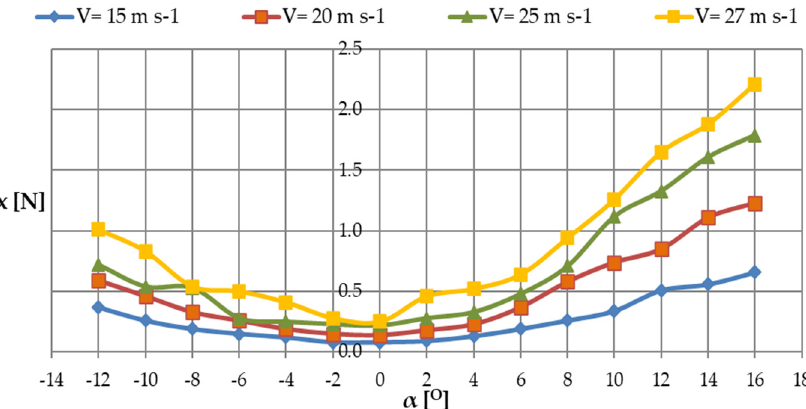
Figure 11. Summary plot of drag force, Px, for positive and negative angles of attack, α , for all airflow speeds tested.